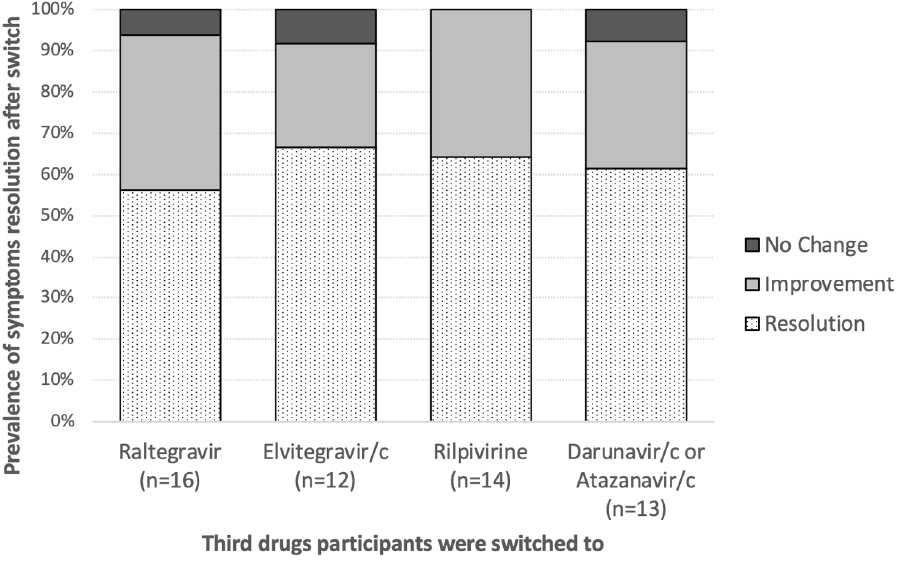
Figure 3. Prevalence of neuropsychiatric symptom resolution after dolutegravir discontinuation ac- cording to the antiretrovirals patients were switched to. according to the antiretrovirals patients were switched